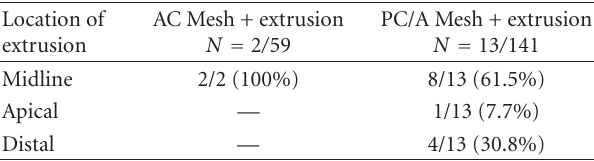
Table 3: Extrusion location (PROPEL